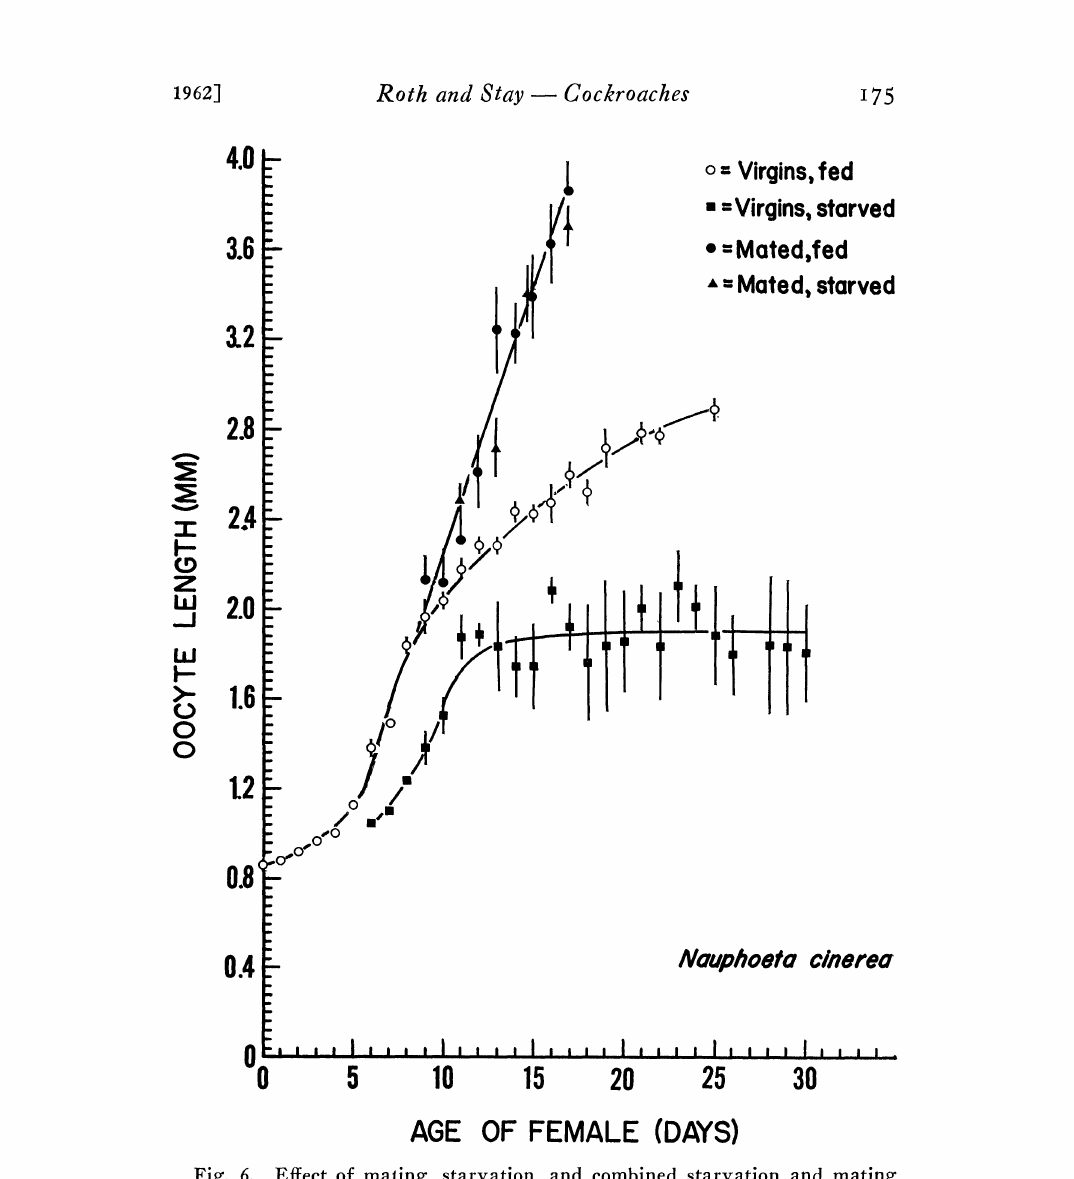
Fig. 6. Effect of mating, starvation, and combined starvation and mating on oiScyte development in Nauphoeta cinerea. The points are mean values" fed virgins, N--707; starved virgins, N--133; fed mated, N--58; starved mated, N--21. Females were mated when 4 to 6 days old. Vertical bars are one standard error (only positive halves of standard errors are indicated wherever errors overlapped); no vertical bars indicate standard errors of ----_0.02 mm. or